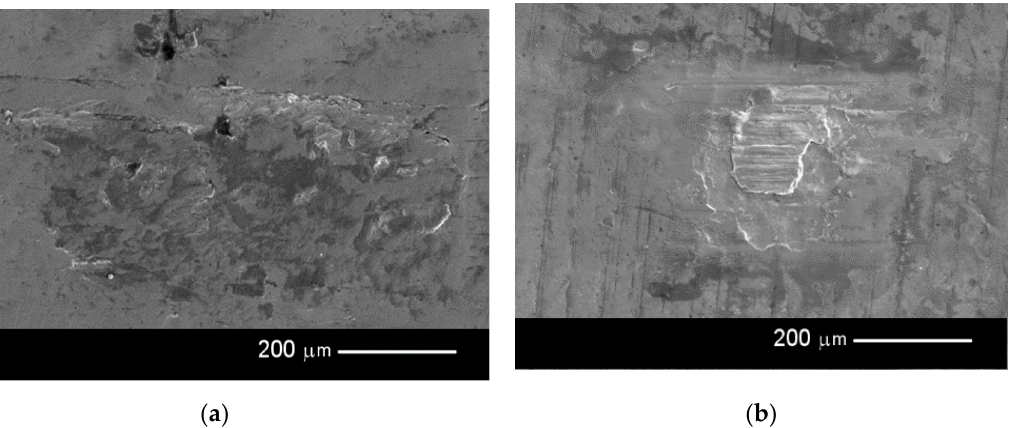
Figure 5. Images of friction tracks obtained with the load of 15 N and for the time of 120 min. ( a ) Sample S0; ( b ) Sample S5.